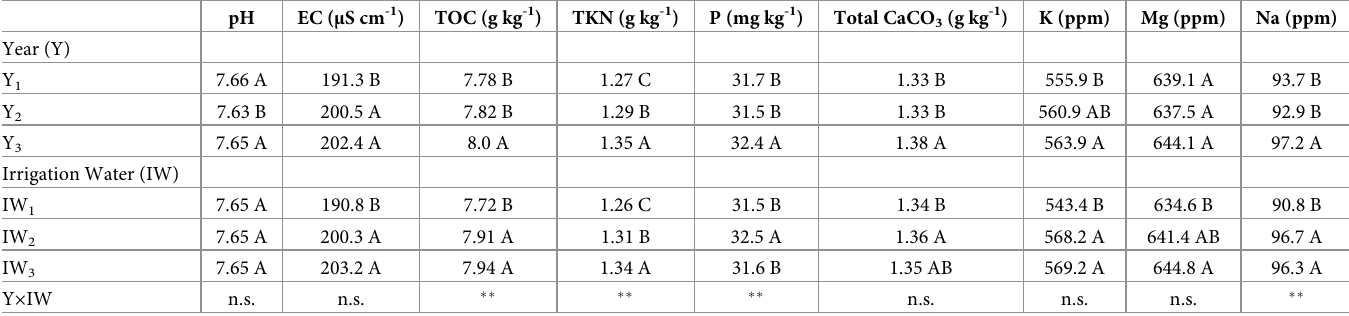
Table 10. Chemical characteristics of soil in response to year and irrigation water during the study period. Average values of 3-year tests are shown.